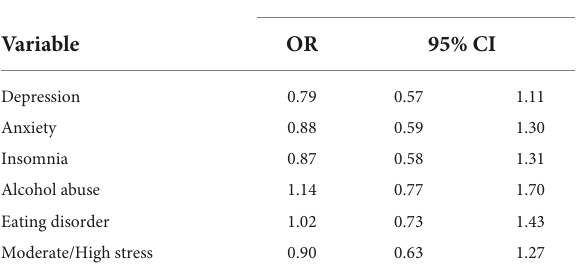
TABLE 6 Adjusted odds ratios (ORs) stratified by partnership status with being single as the reference category. Partnership vs.